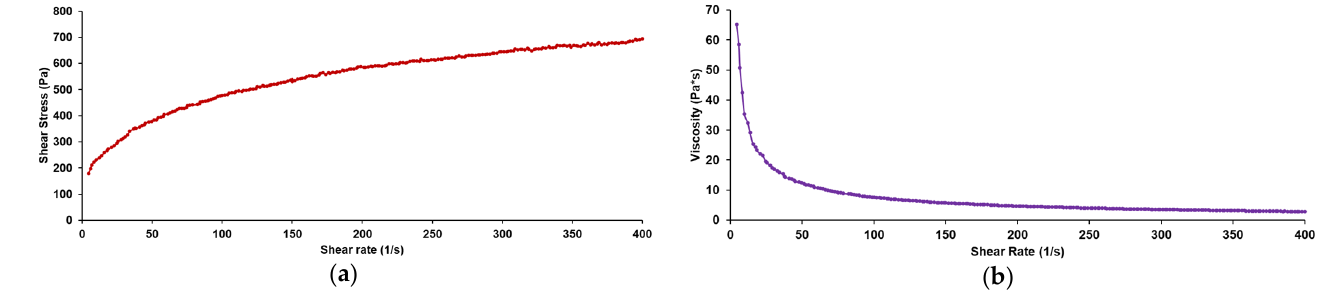
Figure 8. Curve of shear stress vs. shear rate ( a ) and viscosity vs. shear rate ( b ) of CP1_1.1-Hgel by rheological experiments (Pa*s in Figure 8b means Pa × s).